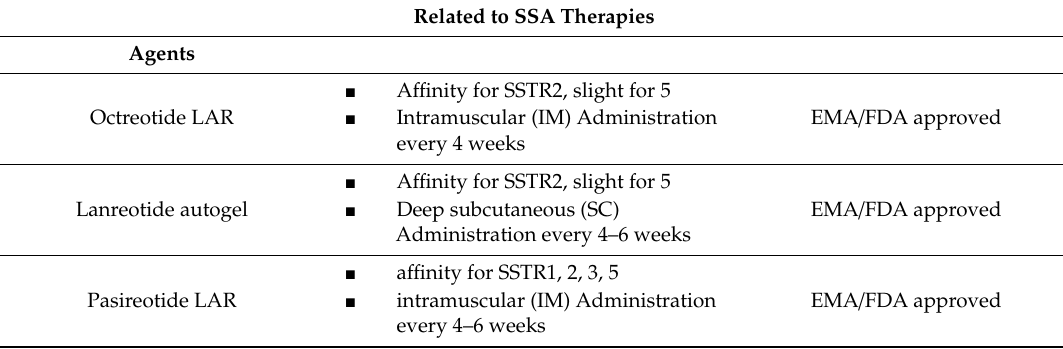
Table 1. New pharmaceutical agents currently used or in future use for the medical therapy of